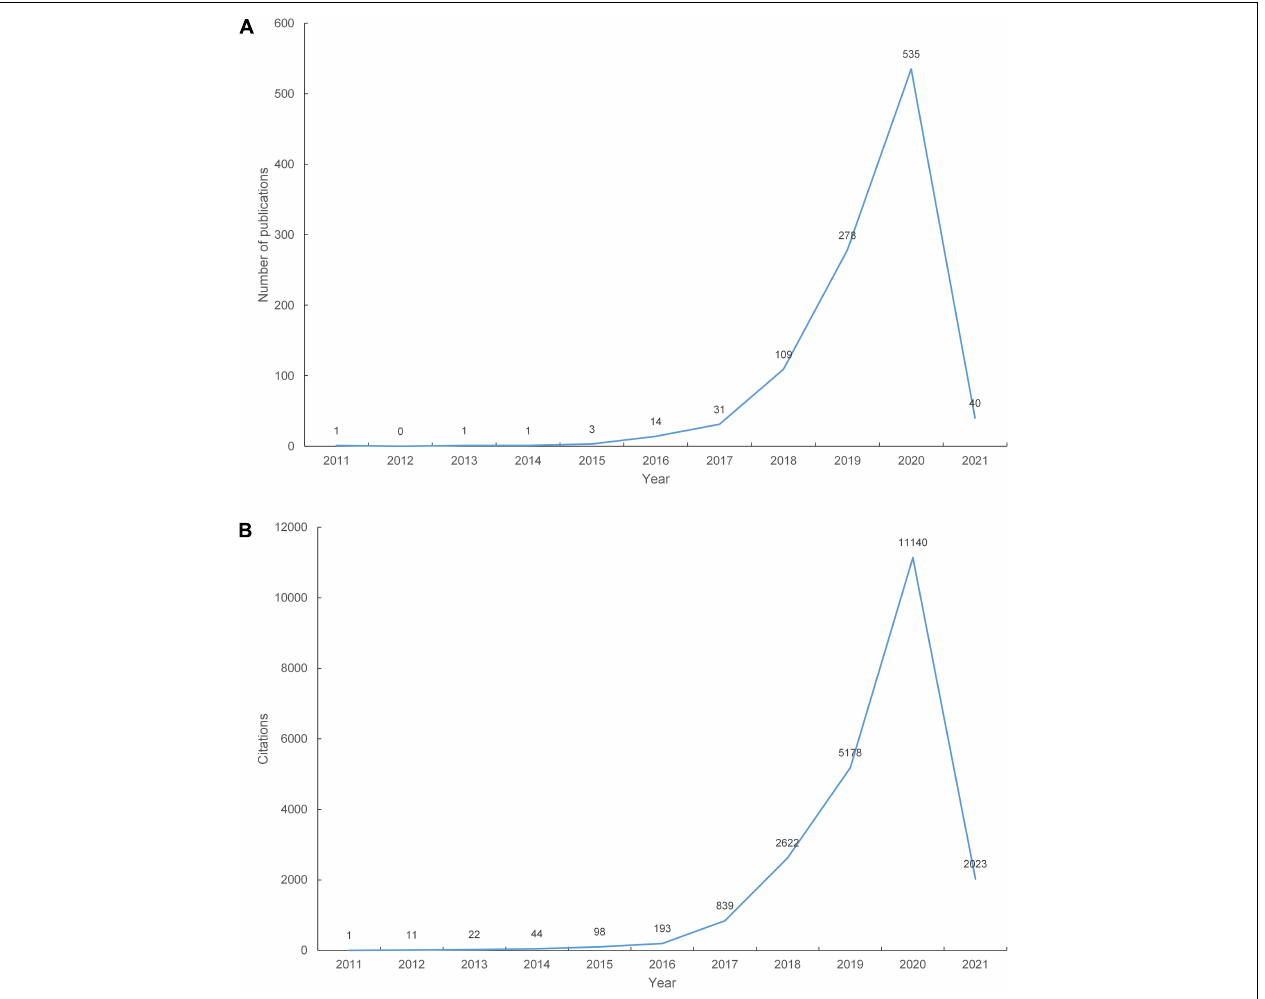
FIGURE 1 | The number of publications and citations. (A) The number of annual publications on the crosstalk between microRNAs and circular RNAs from 2011 to 2021; (B) The number of annual citations on the crosstalk between microRNAs and circular RNAs from 2011 to 2021.